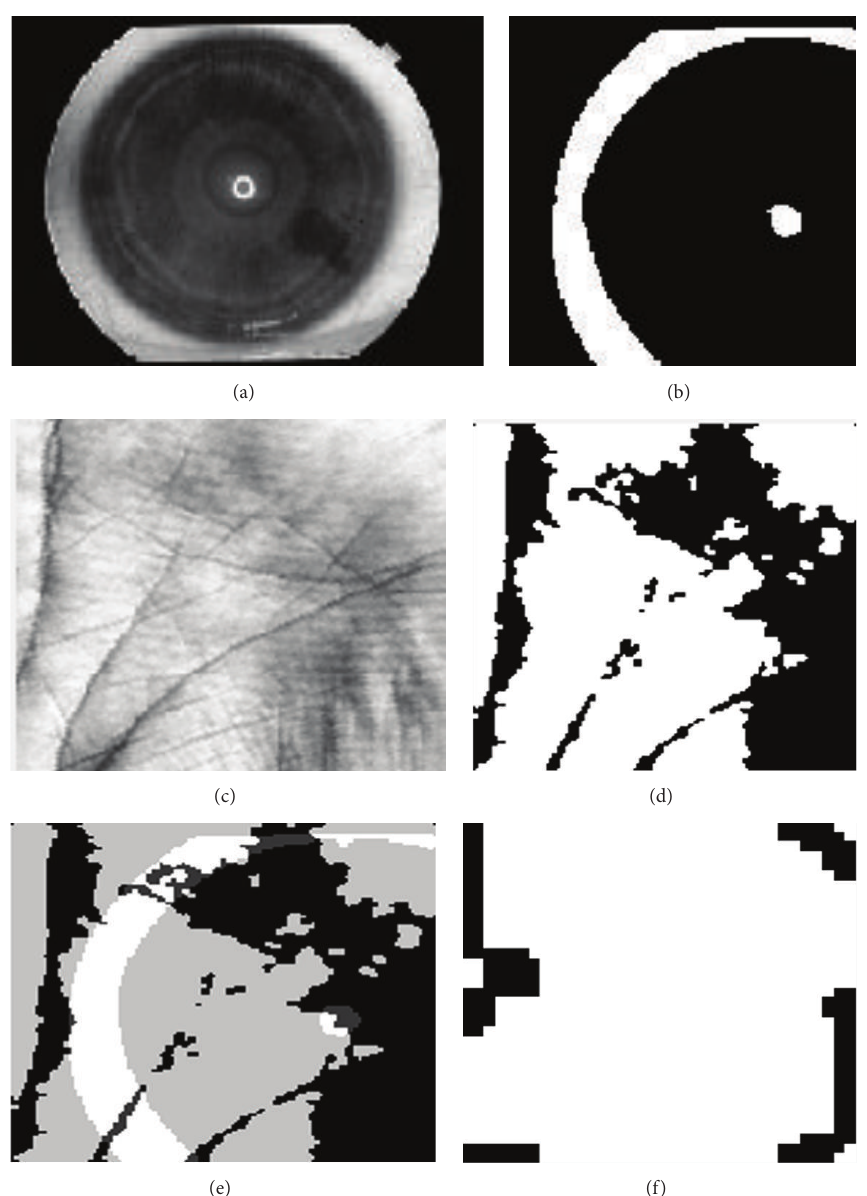
Figure 6: Feature fused image: (a) eye image, (b) preprocessed eye image, (c) palmprint image, (d) preprocessed palmprint image, (e) feature fused image, and (f) segmented